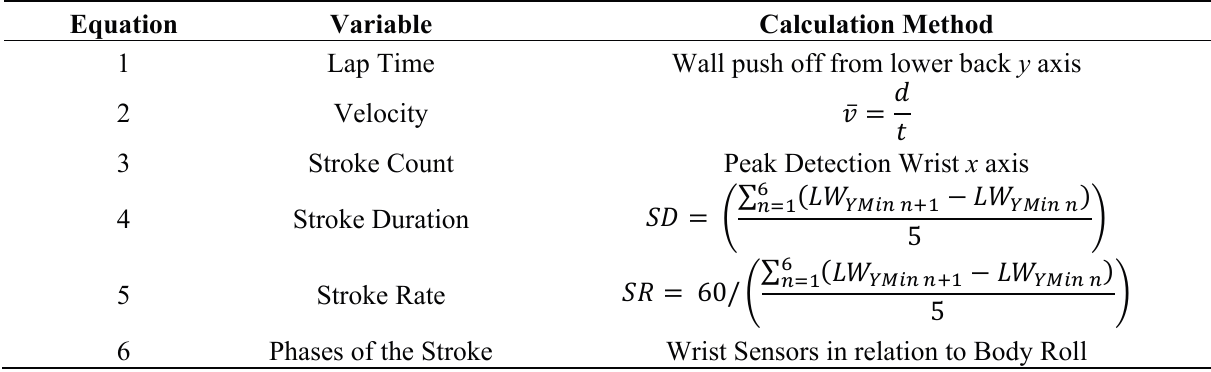
Table 2. Variables and calculation